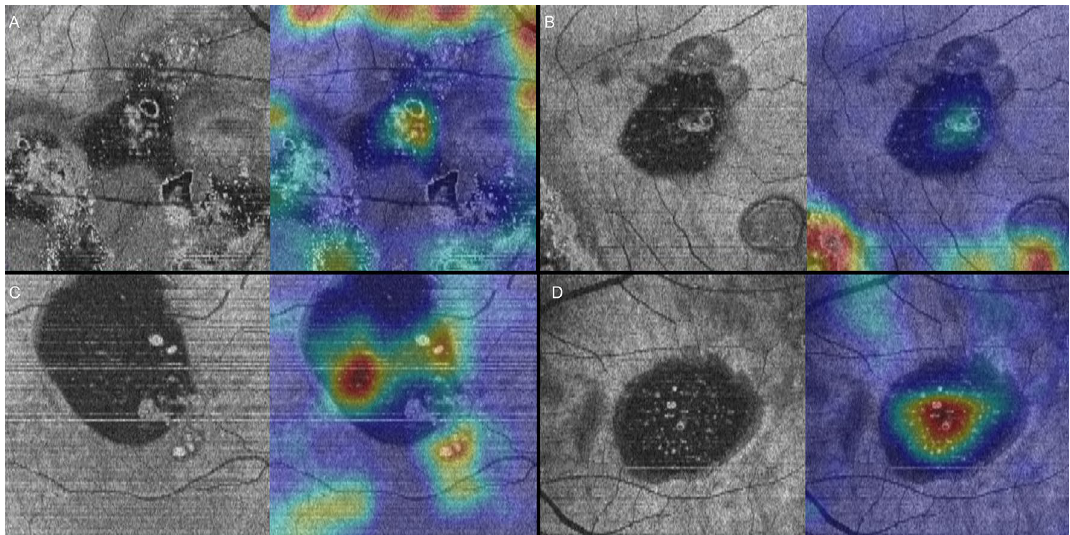
Figure 2. Four representative cases of persistent Grad-CAM analysis on OCT en face images of the ellipsoid zone (EZ) layer. ( A – D ) A heatmap overlying the OCT en face image of the EZ layer highlights areas of the neurosensory retinal detachment with or without outer retinal defects within the main lesion in all cases. Areas of the neurosensory retinal detachment with or without outer retinal defects outside the main lesion are important in Cases A and B.